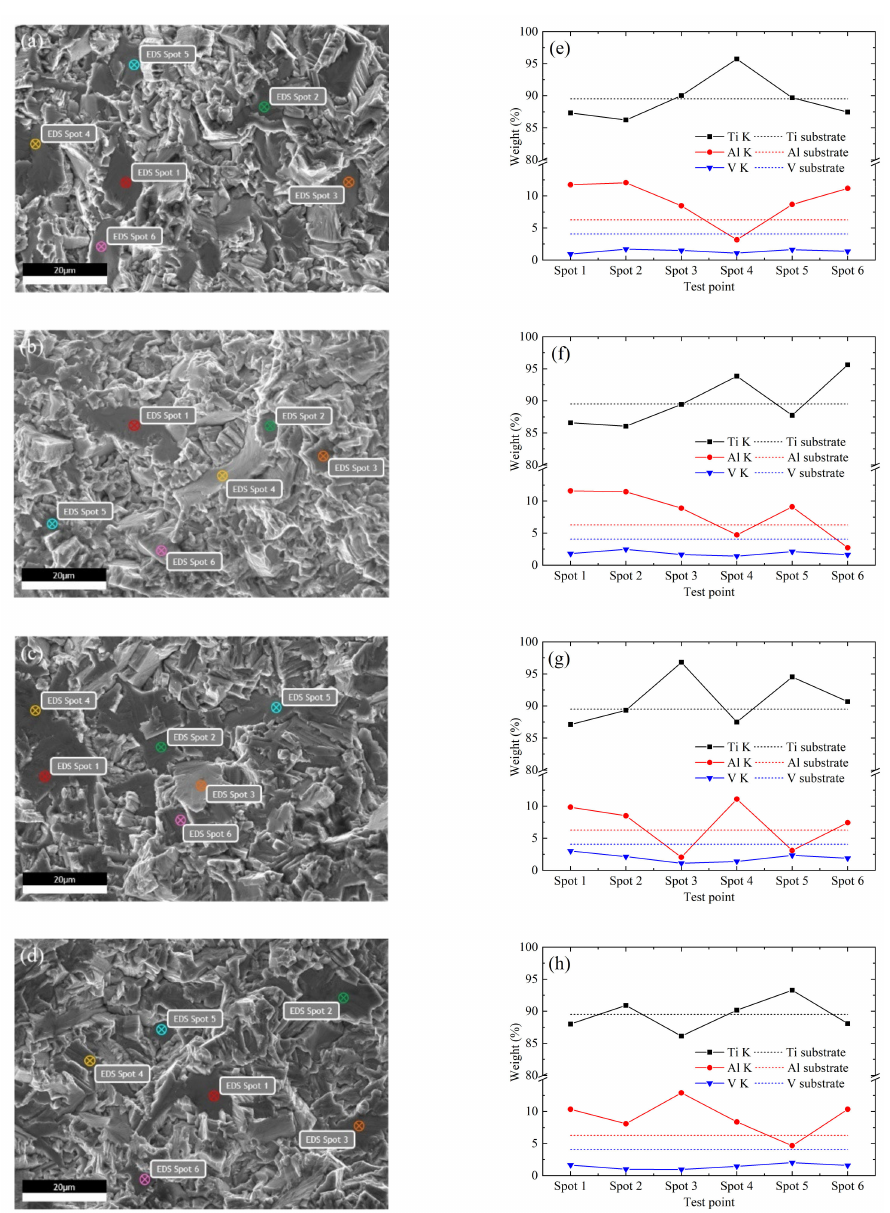
Figure 10. EDS analysis of facets in ultra-high-cycle-fatigue crack origin zone. ( a , e ) Equiaxed I, × 10 8 ; ( b , d ) equiaxed II, σ a = 233 MPa, N σ a = 218 MPa, N f = 6.06 × 10 8 ; ( g , h ) bimodal II, σ a = 233 MPa, N σ a = 225 MPa, N f = 4.15